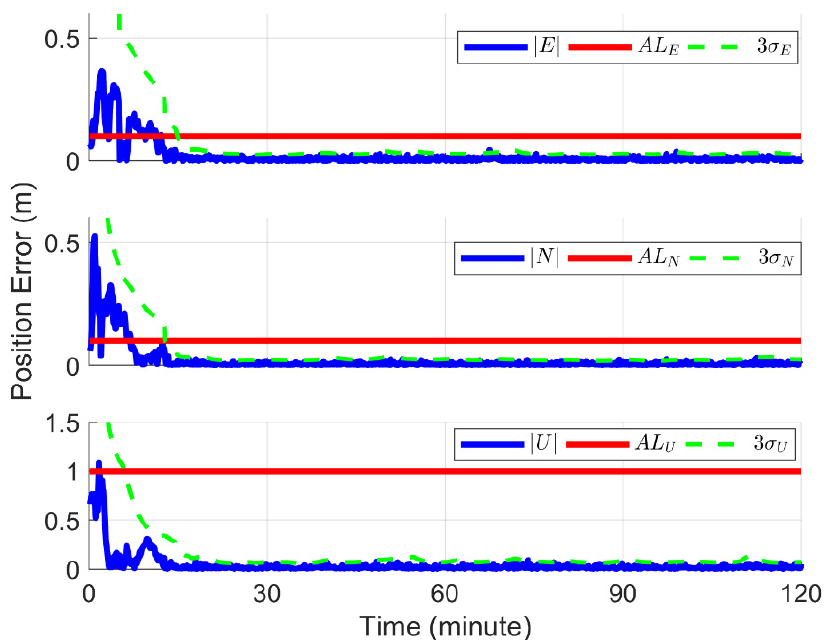
Figure 3. The PEs, three times of updated STDs and ALs for the east (E, top ), north (N, middle ) and up (U, bottom ) directions of the simulated PPP.